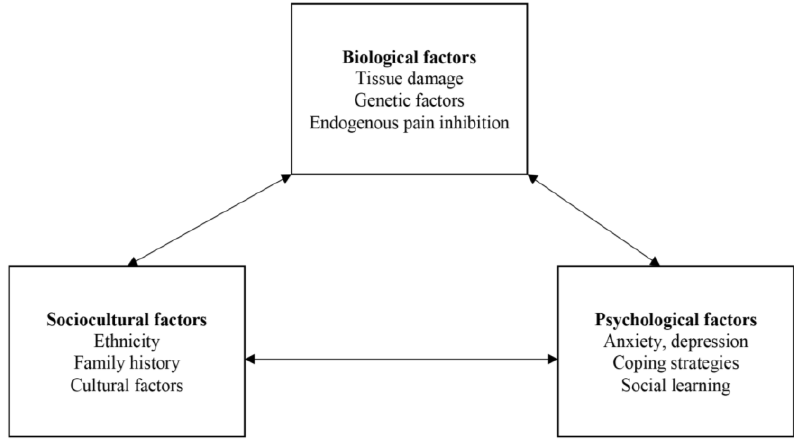
Figure 1. The Biopsychosocial Model of Pain [29].